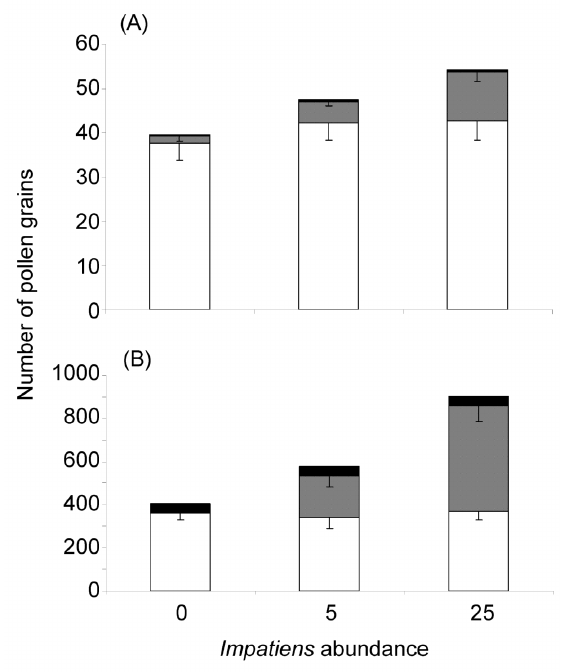
F IG . 5. Origin (white: conspecific, grey: alien, black: other) and quantity of pollen grains deposited on stigmas of native species according to I. glandulifera abundance (0, 5 and 25 individuals). stigmatic lobe per flower). Data were collected in 2008 in plots adjacent to I. glandulifera and are presented as mean ± s.e. (n = 24- 30 flowers).